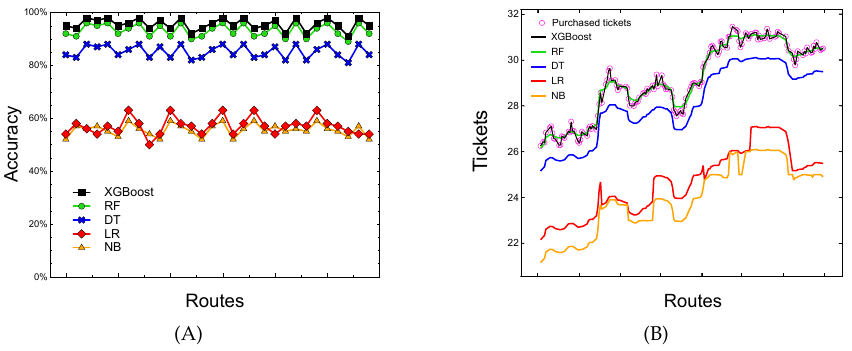
Fig.9. Comparison among Na¨ıve Bayes (NB), Logistic Regression (LR), Decision Tree (DT) and Random Forest (RF). Figure 8. Accuracy obtained ( A ) and number of predicted tickets ( B ) by Naïve Bayes (NB), Logistic Regression (LR), Decision Tree (DT), Random Forest (RF) and eXtreme Gradient Boosting